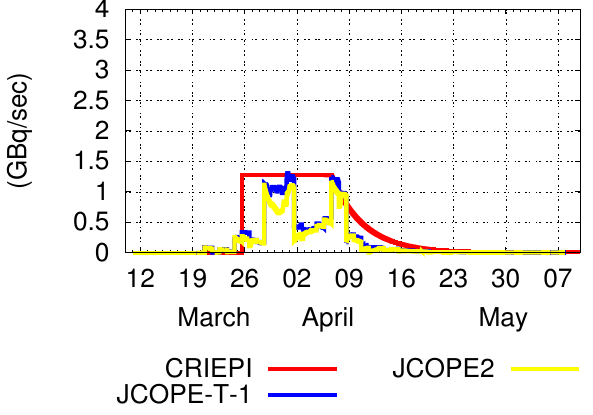
Fig. 4. Time sequences of the first-guess direct release